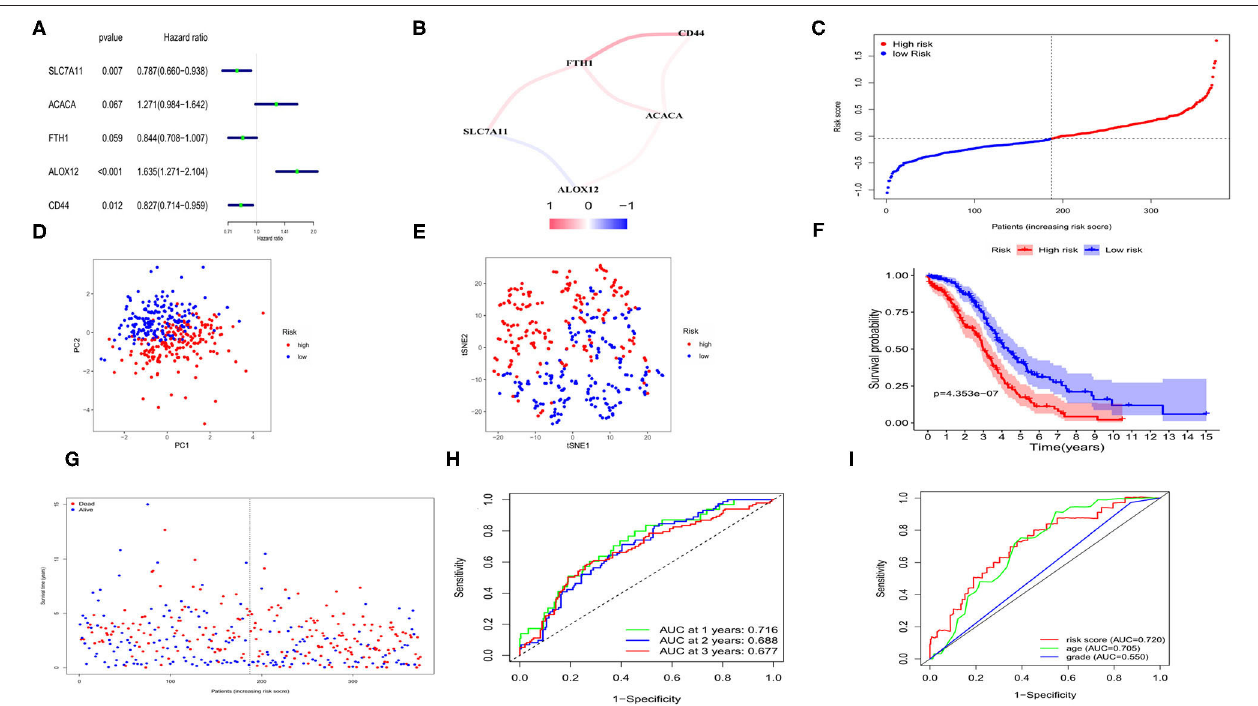
FIGURE 3 | Construction of risk signature for OCs in TCGA cohort. (A) Screen out of the OS-related genes with univariate cox regression analysis. (B) The correlation network of the OS-related genes. (C) Risk score for OCs. (D) PCA plot for OCs. (E) t-SNE analysis for OCs. (F) Kaplan-Meier curves for the OS of patients in the high- and low-risk group based on risk score. (G) Survival status for each patient. (H) ROC curves demonstrated the predictive efficiency. (I) Multi-indicator ROC curves for risk score, age and tumor grade.